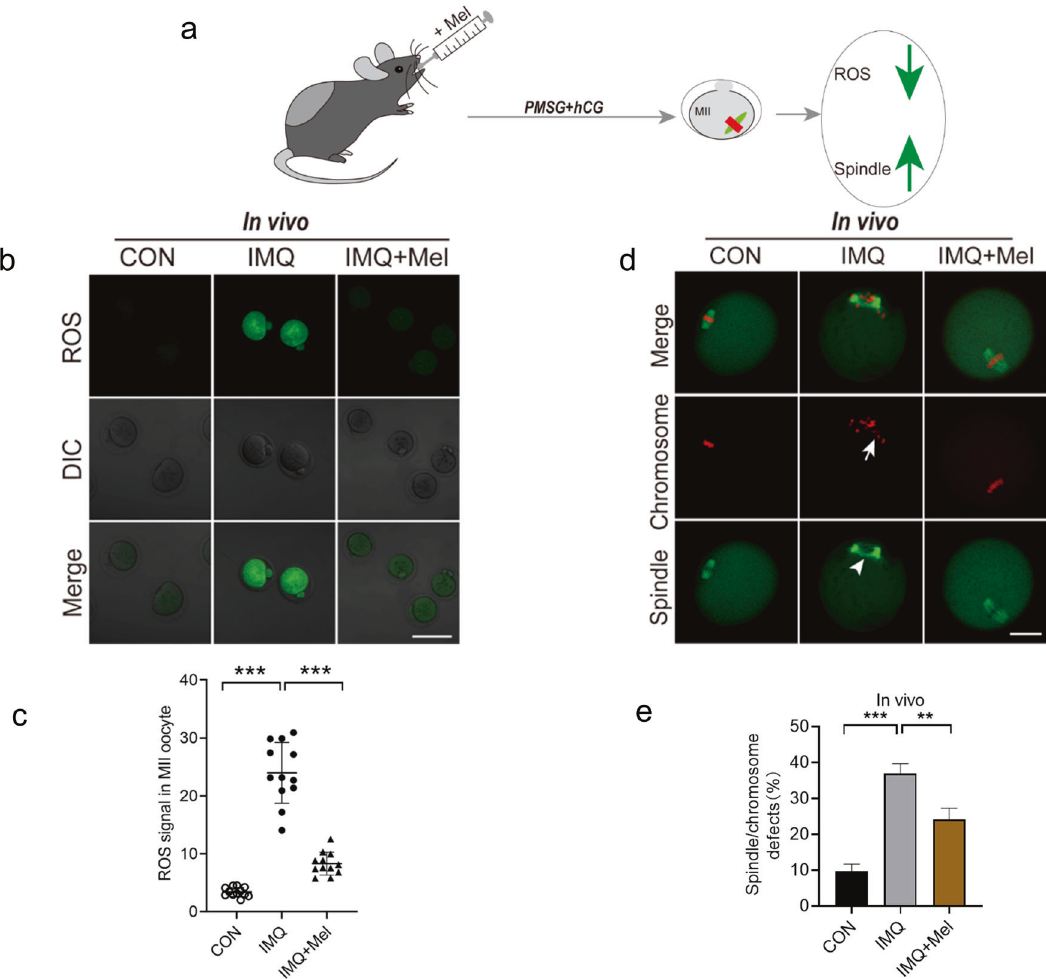
Fig. 7 Effects of in vivo administration of melatonin on ROS generation and meiotic apparatus in oocytes that matured in vivo from psoriasis-like mice. a Diagram of in vivo administration of melatonin and oocyte that matured in vitro. b The images showing ROS fl uorescence (green) in CON, IMQ, and IMQ + Mel oocytes. Scale bar: 150 µm. c Quanti fi cation of ROS signal intensity ( n = 17 for each group). d Confocal images of spindle morphologies and chromosome alignment in the CON, IMQ, and IMQ + Mel oocytes. Scale bar: 30 µm. e Quanti fi cation of spindle defects and chromosome disalignment in oocytes. CON ( n = 109), IMQ ( n = 105), and IMQ + Mel ( n = 125) oocytes were tested. The data were shown as mean ± SD. ** P < 0.01, *** P <